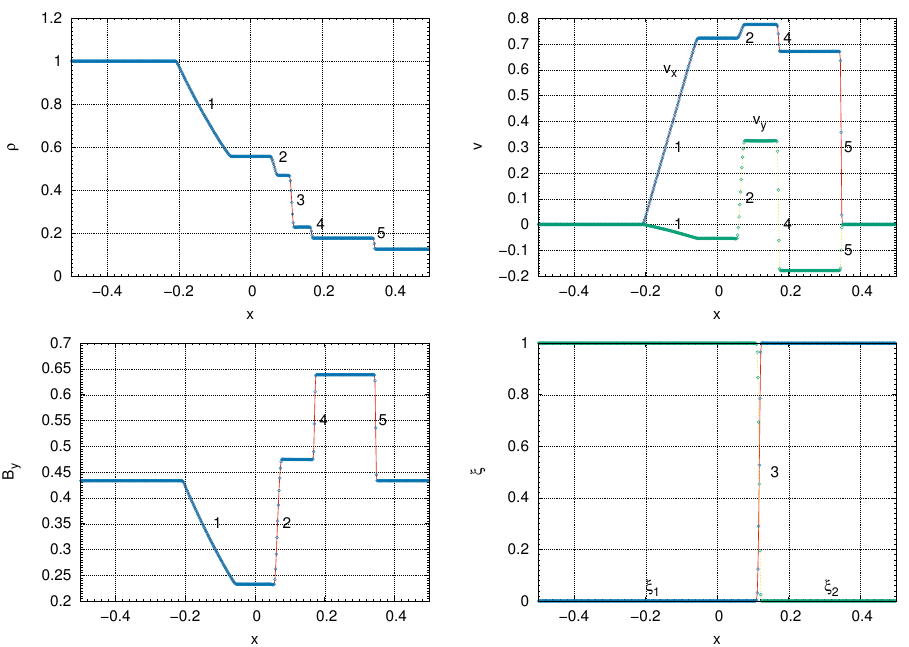
Figure A1. The results of the test calculation of the Riemann problem on the decay of an arbitrary discontinuity (see the description of the initial conditions in the text). Density distributions are shown ( top left ), velocity components v x and v y ( top right ), magnetic field components b y ( bottom left ), as well as mass fractions ξ 1 and ξ 2 ( bottom right ) at time t = 0.15. The figures correspond to